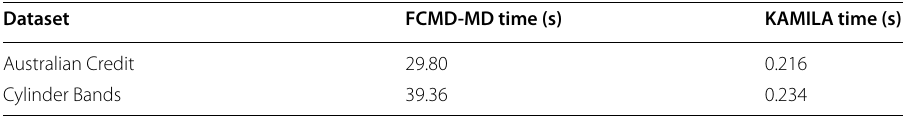
Table 7 Time consumption comparison of KAMILA and FCMD-MD Dataset